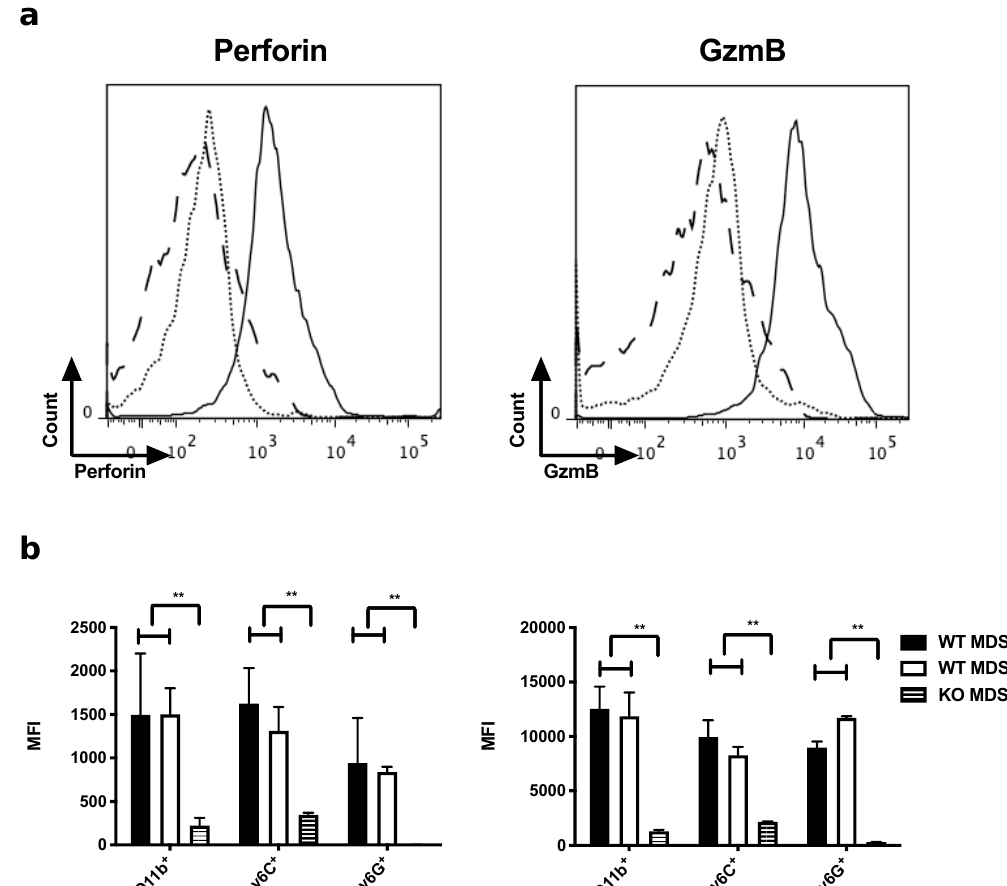
Figure 1. In vitro MDSCs express perforin and GzmB. ( a , b ) MDSCs were generated starting from bone marrow of WT or perforin / GzmB knock out mice (KO) mice using the CM of tumor cells. ( a ) Representative histograms showing perforin (left) and GzmB (right) expression by in vitro WT (full line) or KO (dotted line) MDSCs (gated on CD11b + cells) compared to the isotype control (long dashed line), generated using the CM of B16F10-GM-CSF cells. ( b ) Summarizing graphs showing the mean fluorescence intensity (MFI) of perforin (left) and GzmB (right) of in vitro MDSCs (CD11b + ) and of M-MDSCs (CD11b + Ly6C + ) and PMN-MDSCs (CD11b + Ly6G + ), generated using the CM of B16F10-GM-CSF cells (WT MDSC (B16) and KO MDSC (B16)) and the CM of CT26-GM-CSF cells (WT MDSC (CT26)). The mean +/ - standard error of the mean (SEM) of at least three experiments is shown. A student’s t-test was used to calculate statistical significance. The number of asterisks in the figures indicates the level of statistical significance as follows: **, p < 0.01.